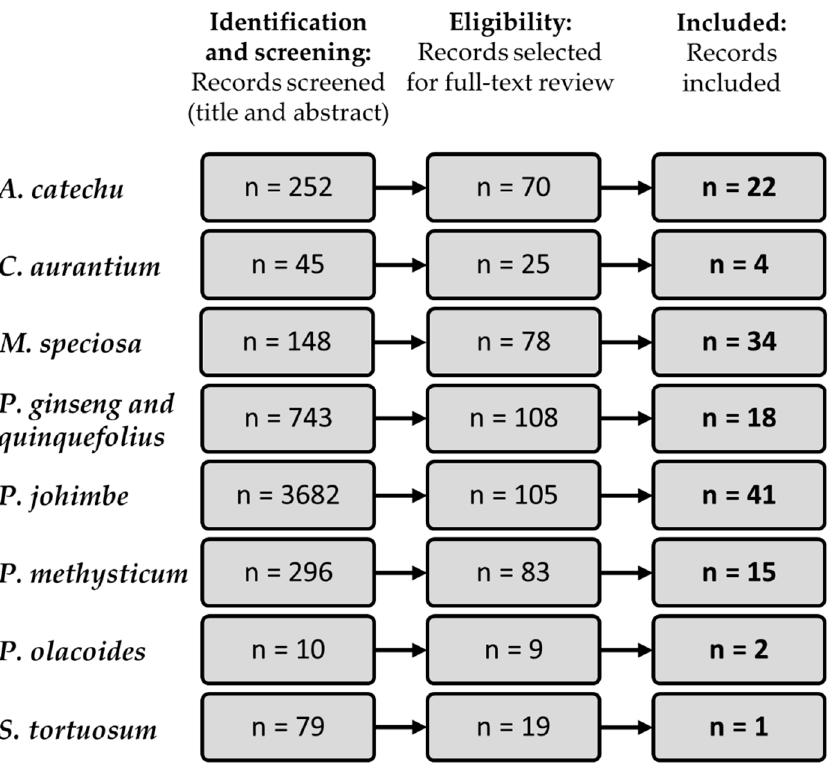
Figure 1. Species-by-species flow diagram of literature search.